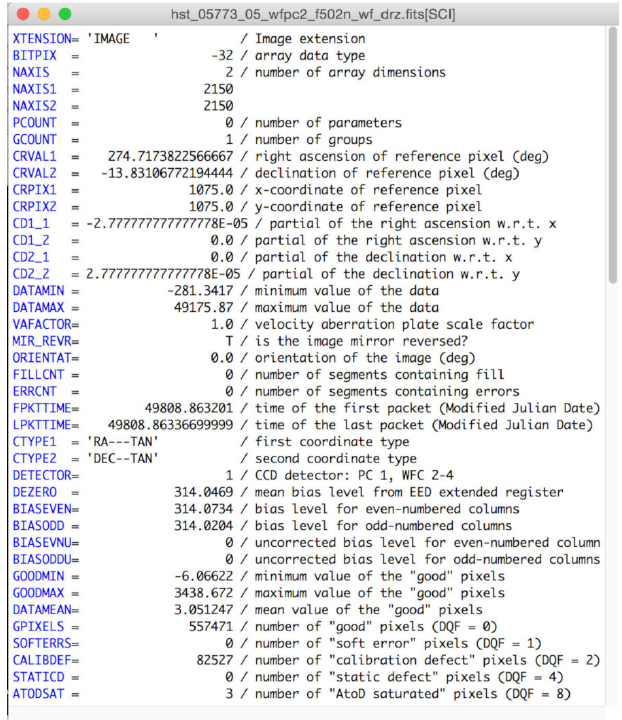
Fig. 39.— Second header of the HST Eagle nebula image